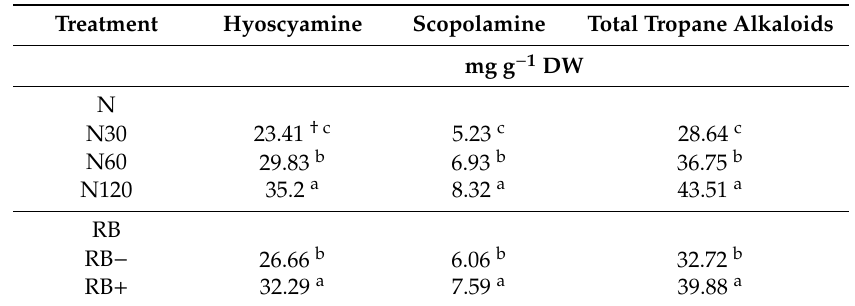
Table 4. E ff ects of mineral nitrogen fertilizer (N) and Rhizobacterein biofertilizer (RB) on hyoscyamine, scopolamine, of total tropane alkaloids content in leaves of Egyptian